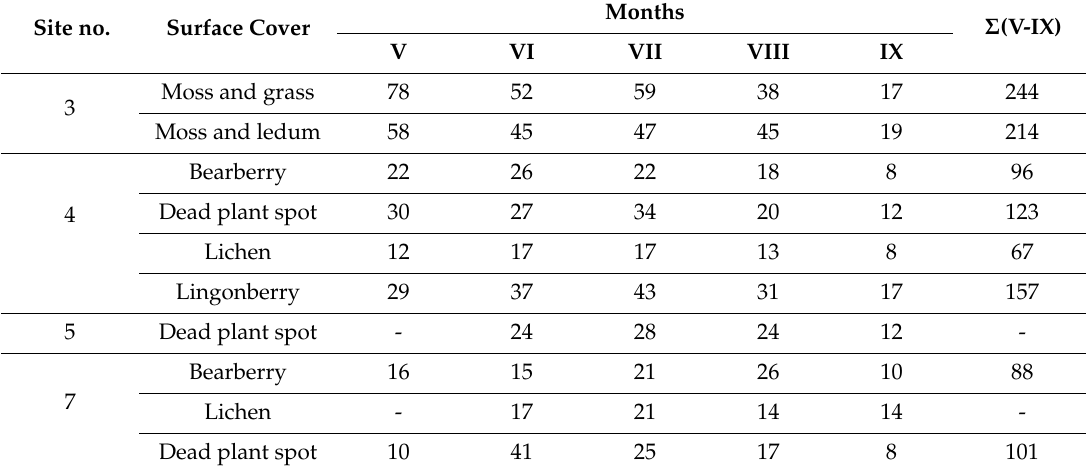
Table 3. Evaporation from the soil surface at the Chabyda sites,